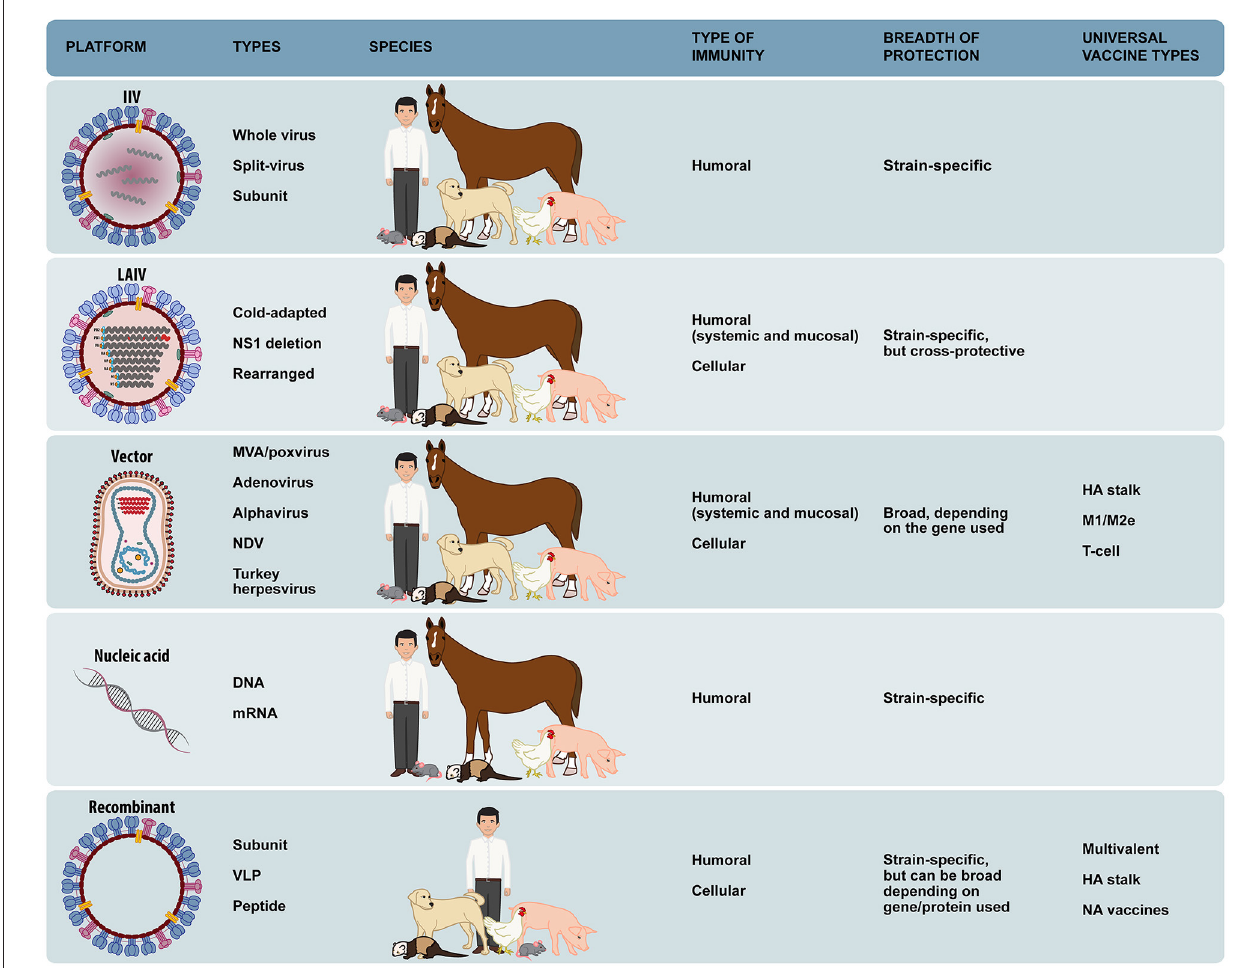
FIGURE 3 | Influenza “universal” vaccine platforms that are used in multiple species or epidemiological situations. Vaccine platform, types of technology, host species, type of immunity stimulated, breadth of protection, and types of universally protective vaccines within each platform are